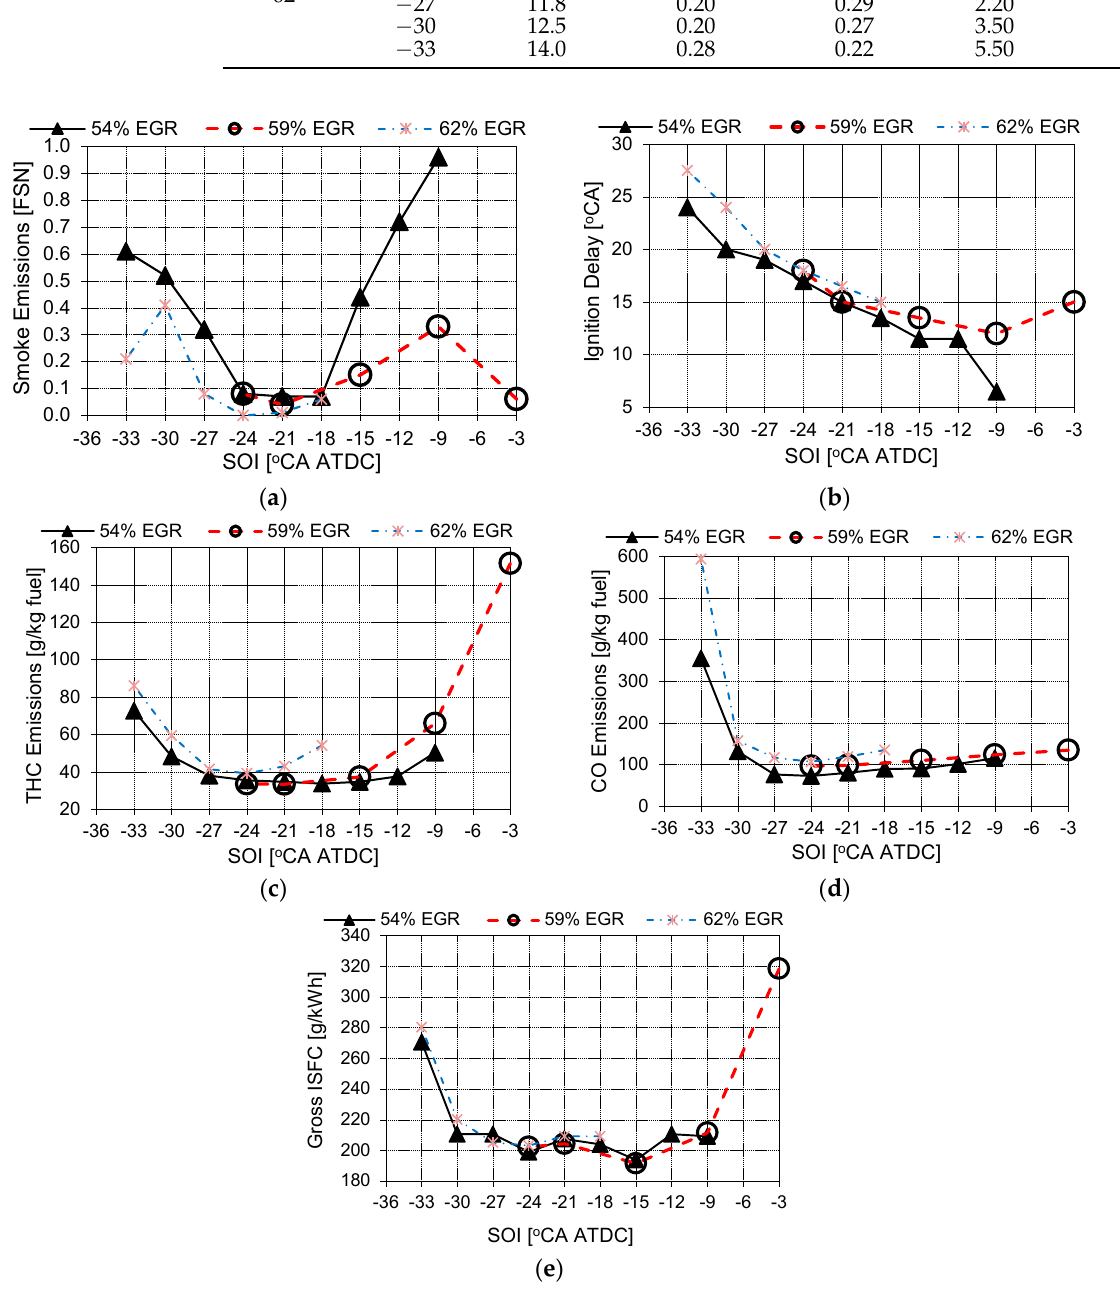
Figure 6. ( a ) Smoke ( b ) ignition delay, ( c ) THC and ( d ) CO emissions and ( e ) GISFC during the SOI sweep at 54%, 59% and 62% EGR rates.